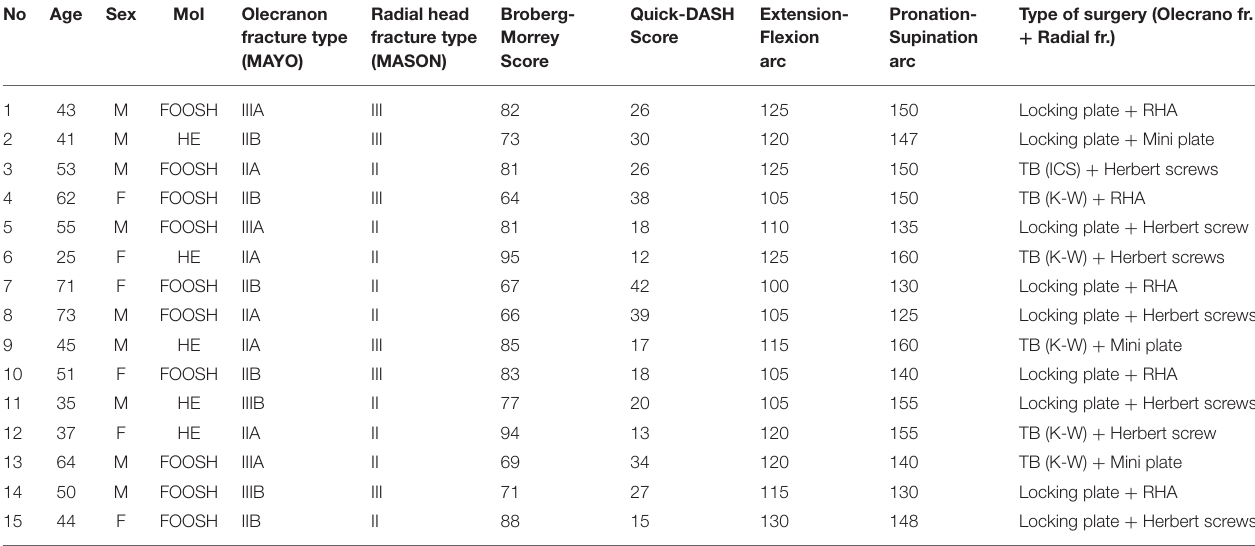
TABLE 1 | Patient’s data.